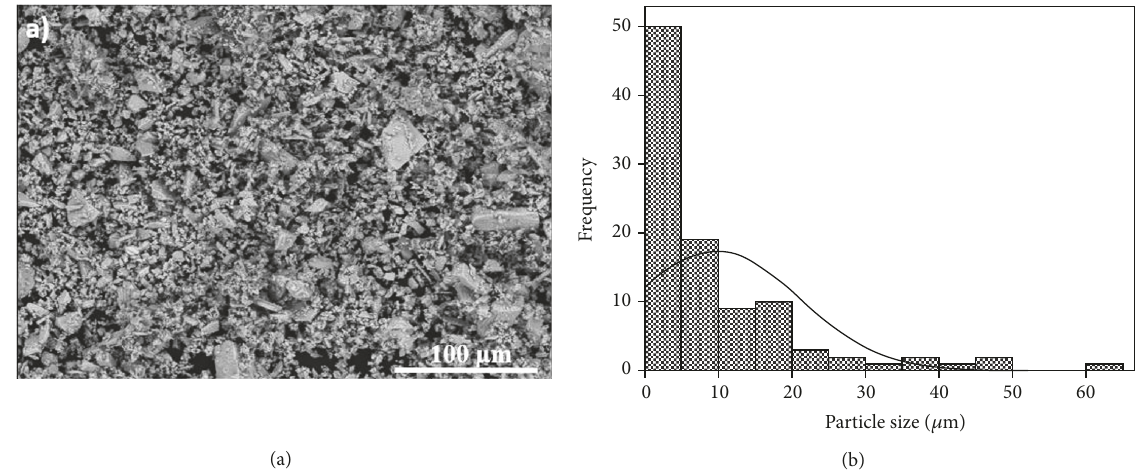
Figure 2: (a) SEM micrograph of P-glass particles and (b) size distribution of particles.